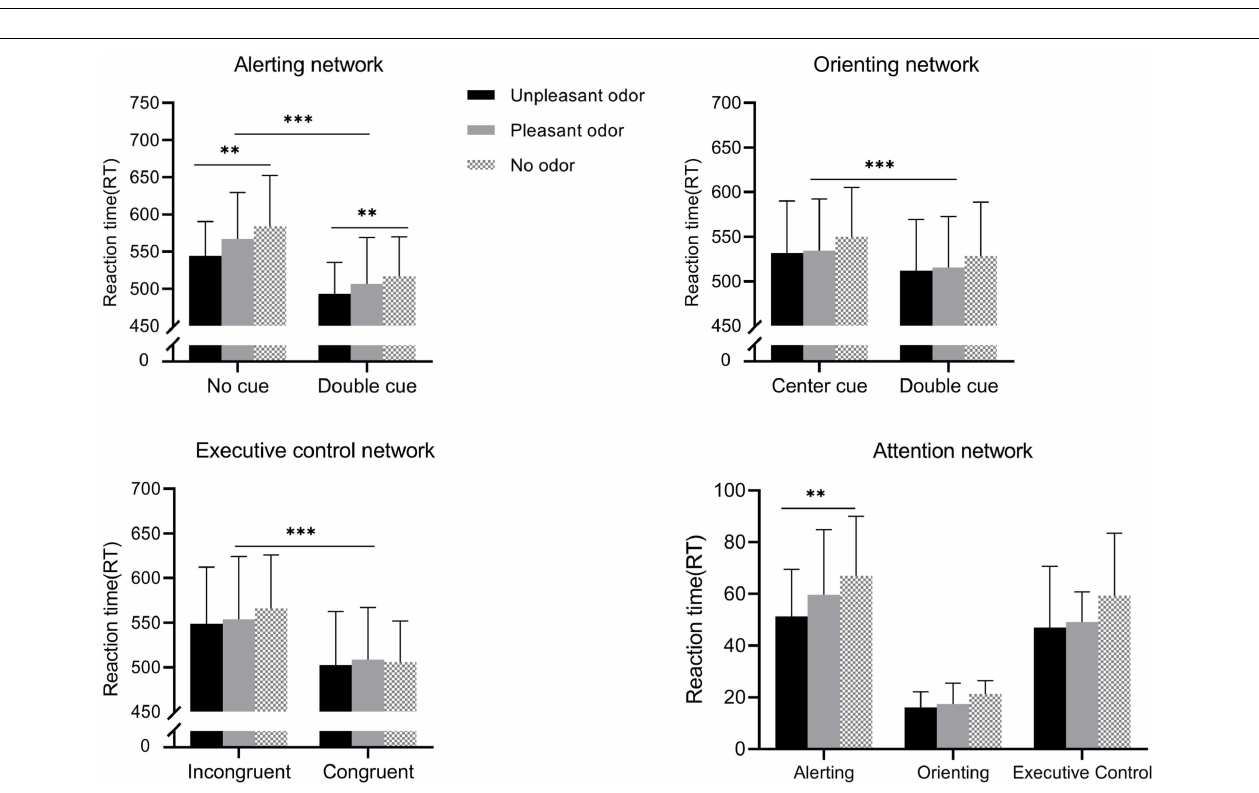
FIGURE 3 | Reaction time (RT) for the different odor conditions for each attention networks. Values represent the mean, and error bars indicate the standard error (SE). ∗∗ p < 0.01; ∗∗∗ p < 0.001.